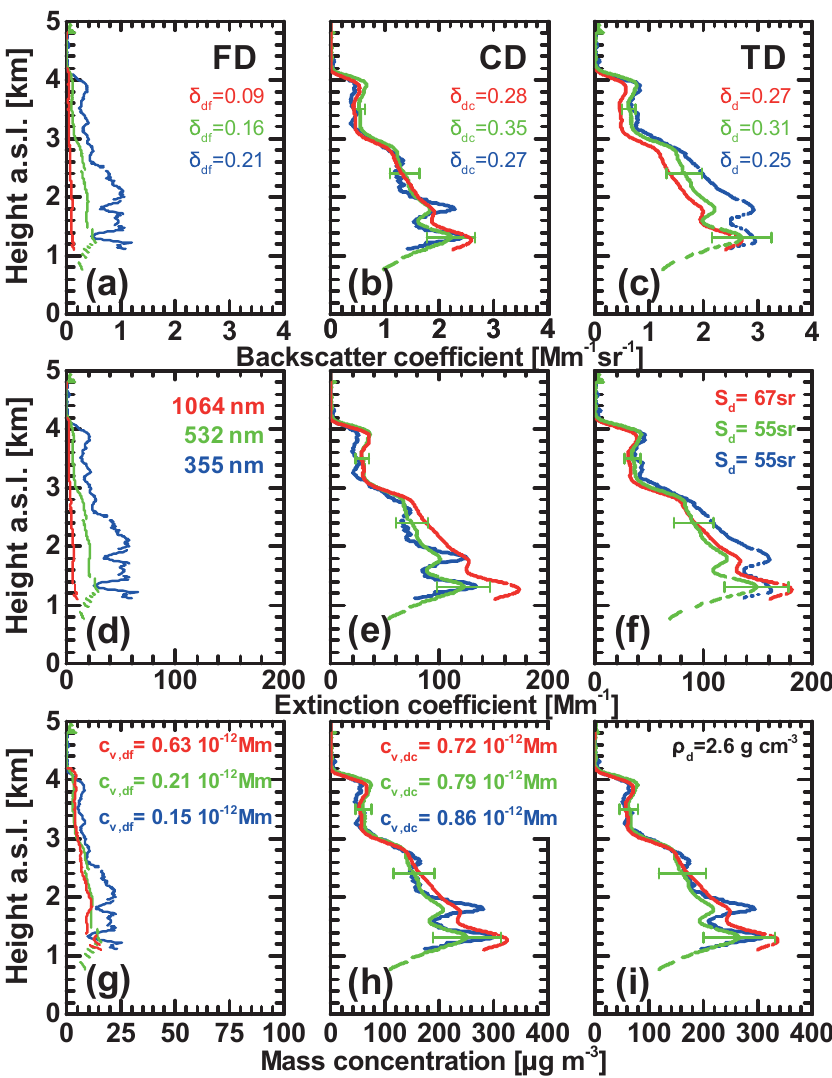
Figure 13. Dust backscatter and extinction coefficients and mass concentrations for fine dust (FD), coarse dust (CD), and total dust (TD) obtained by means of the combined use of the one-step and two-step POLIPHON method, applied to all available polarization lidar data sets (355nm blue, 532nm, green, 1064nm, red). For 532nm the same solutions as in Fig. 11 (scenario 2) are shown. The dust extinction profiles are computed by multiplying the fine, coarse, and total dust backscatter coefficients with the lidar ratio of 55sr (355, 532nm) and 67sr (1064nm). The dust mass concentrations are computed from the extinction coefficients by using the conversion factors in Tables 2 and 3 (given in panels g and h ) and the dust particle density (given in panel i ). Error bars show the overall uncertainty in the case of the coarse and total dust profiles for the 532nm